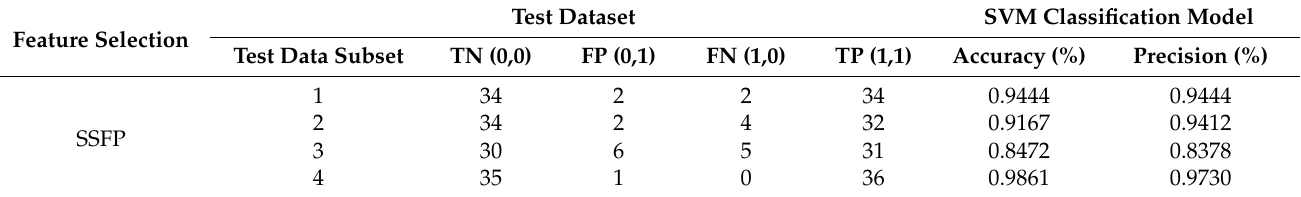
Table 5. Confusion matrix comparison of datasets of SVM classification models based on three feature selection